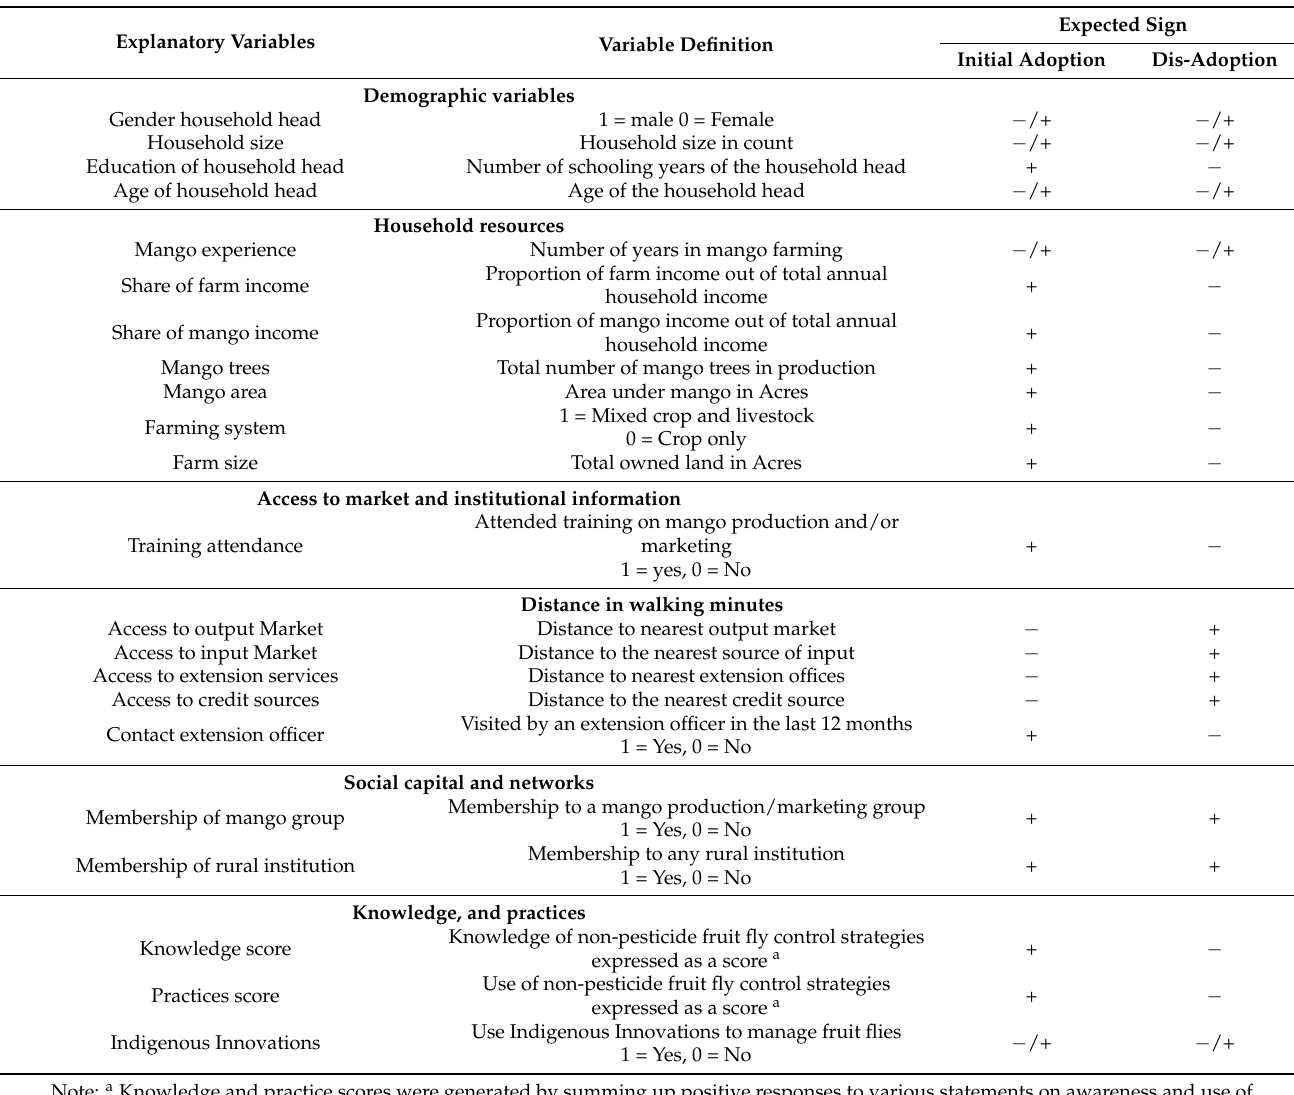
Table 1. Definition of Independent Variables Used in Probit and Multinomial Logit Regression